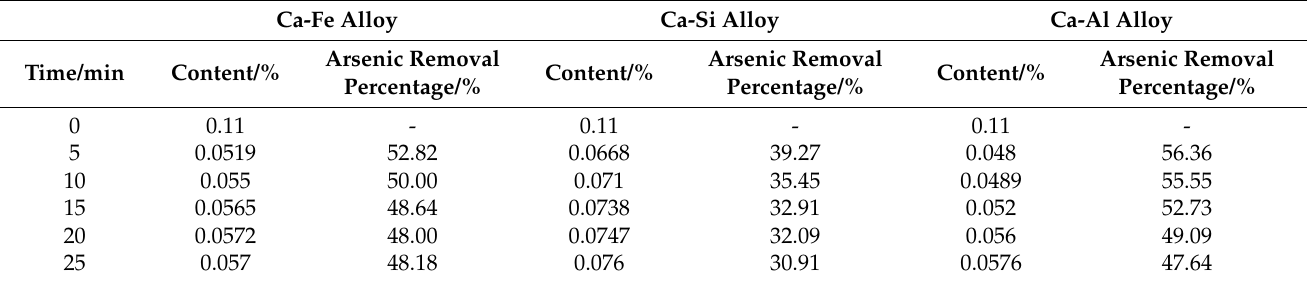
Table 2. Three types of calcium alloy dearsenication agent experiment changes in arsenic content change (wt.%).